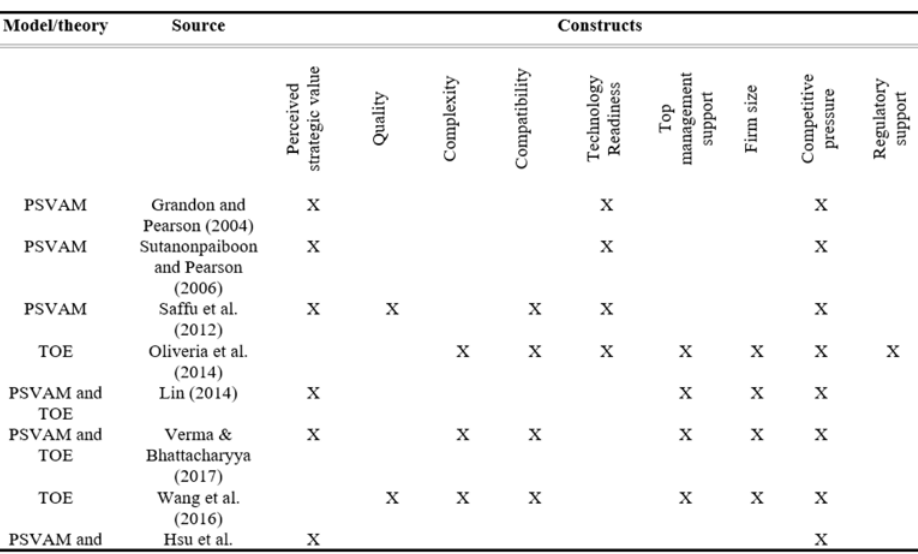
TOE framework and PSVAM framework Model constructs in